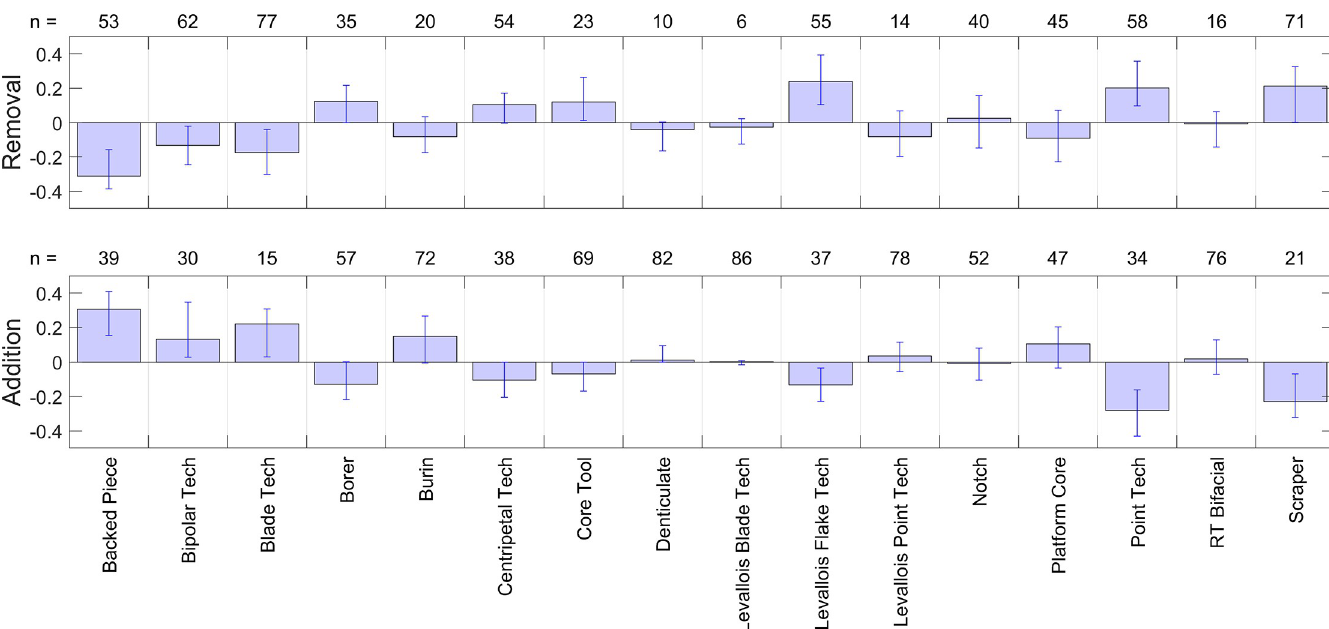
Fig 10. Delta values (2-way). Plots of delta values for the 16 technologies via the bootstrap procedure in the 2-way analysis. Positive values in the ‘Removal’ graph indicate that removing a given technology increases the probability of MSA classification. Positive values in the ‘Addition’ graph indicate that adding a given technology increases the probability of LSA classification. Error bars are 2.5 and 97.5 percentiles.